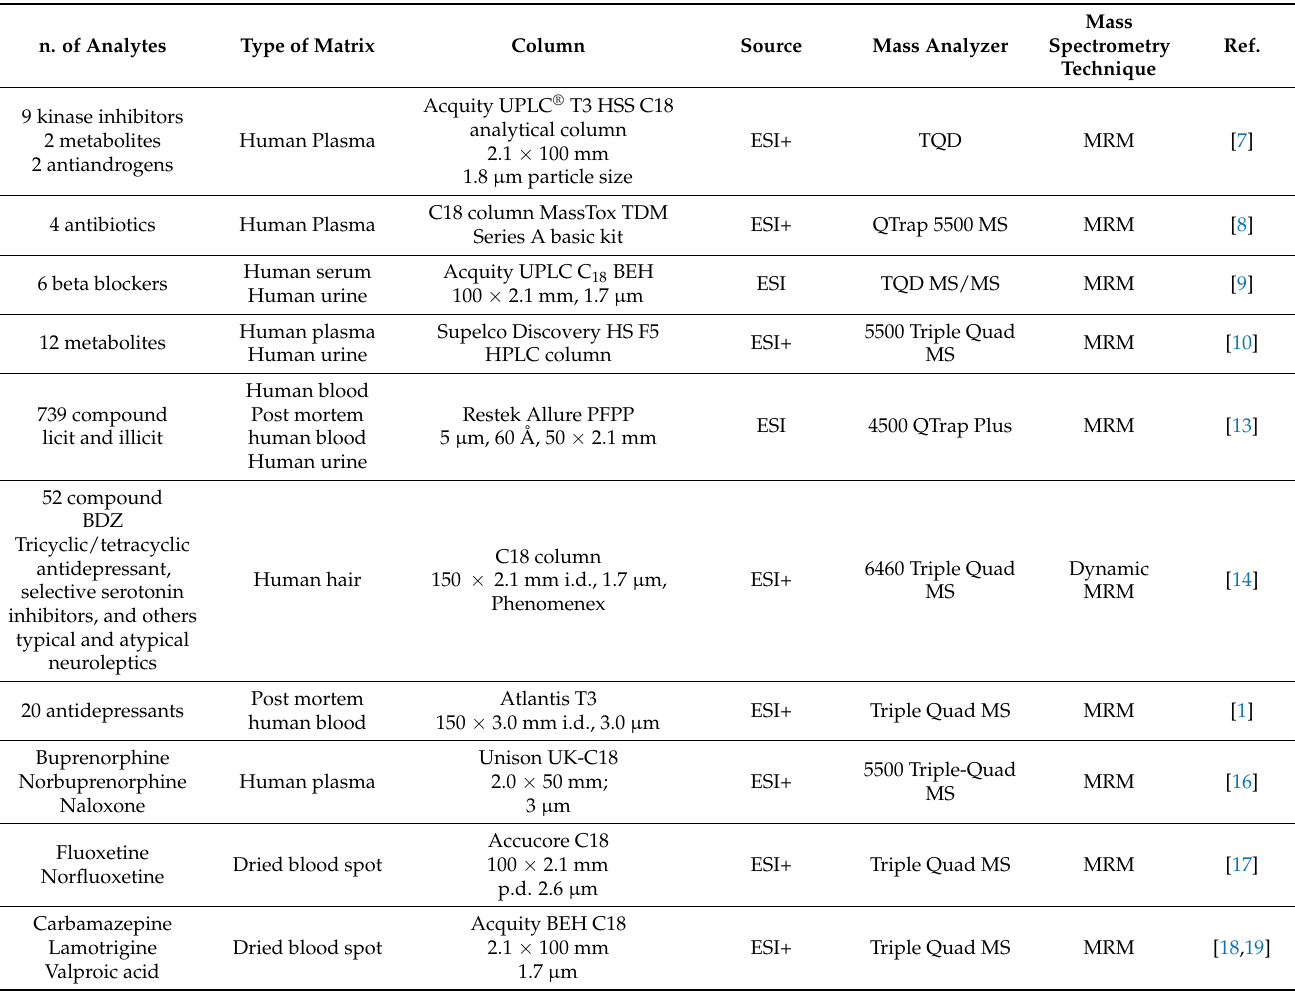
Table 1. LC-MS/MS